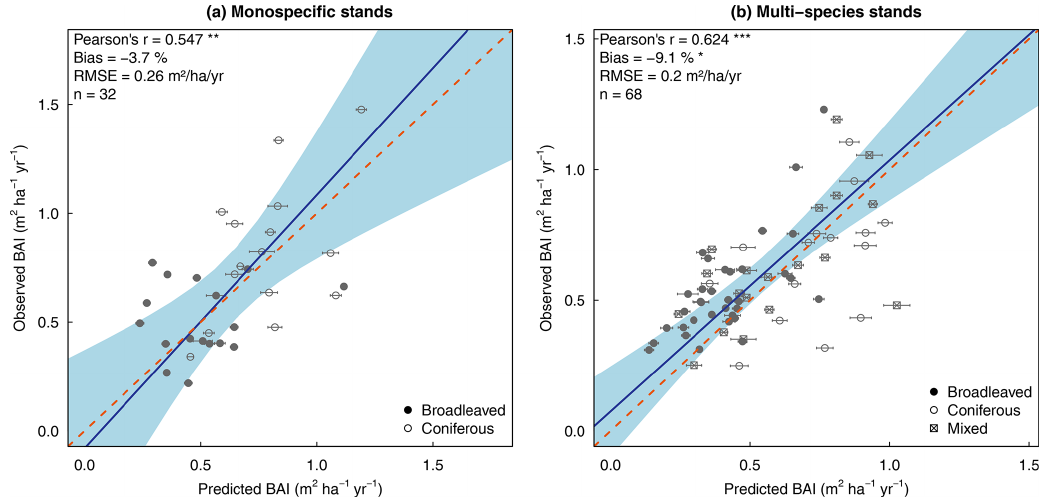
Figure 5. Observed versus predicted basal area increment at the stand level for the 100 stands of the evaluation dataset, grouped by forest type: monospecific stands (left panel) vs. multi-species stands (right panel). The blue line represents the Deming regression between observed and predicted values, the light-blue area is the confidence interval at 95%, and the dashed red line corresponds to the 1 : 1 line. Model performance is indicated using Pearson’s r ( p value: ∗∗∗ < 0.001; p value: ∗∗ < 0.01), the relative bias (paired t test – p value: ∗ < 0.05) and the